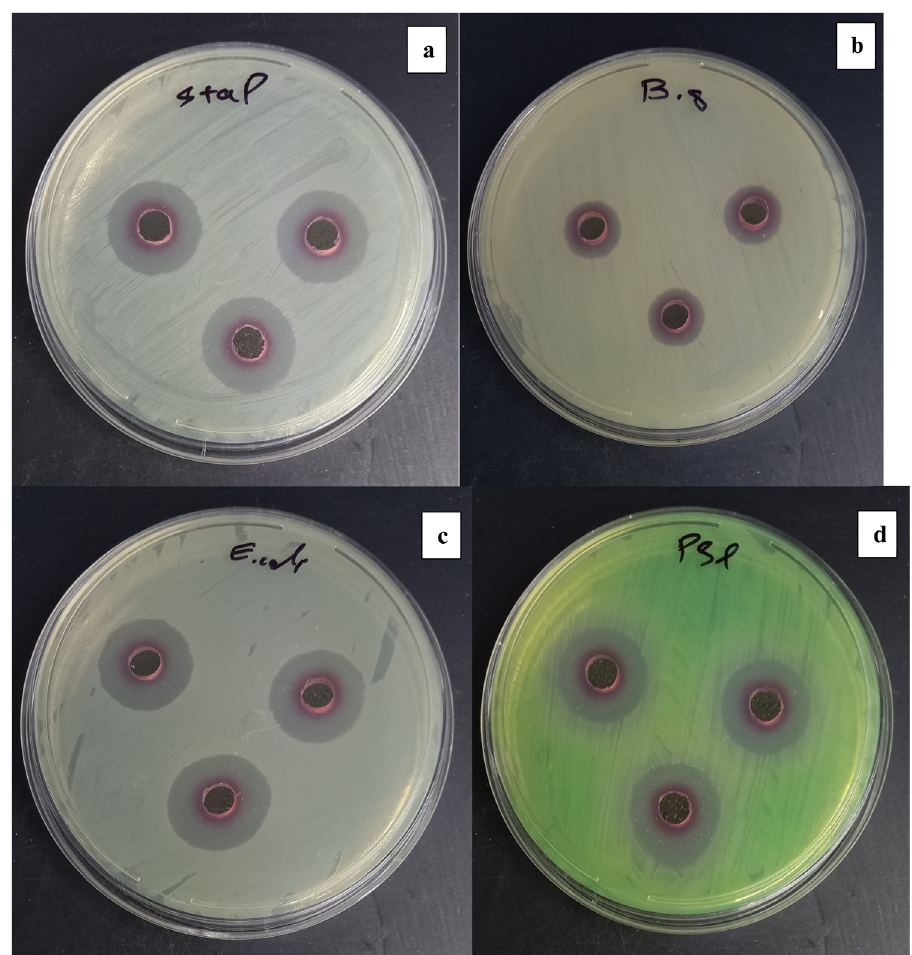
Figure 9: Bactericidal e ff ects of the fabricated Au NPs utilizing A. urumiana extract and UV radiation against S. aureus ( a ) , B. subtilis ( b ) , E. coli ( c ) , and P. aeruginosa ( d )